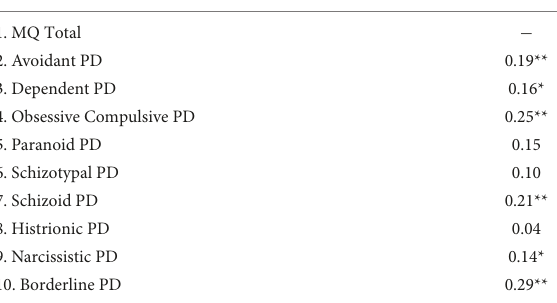
TABLE 5 Correlations between total score on the Misophonia Questionnaire (MQ) and medical health history